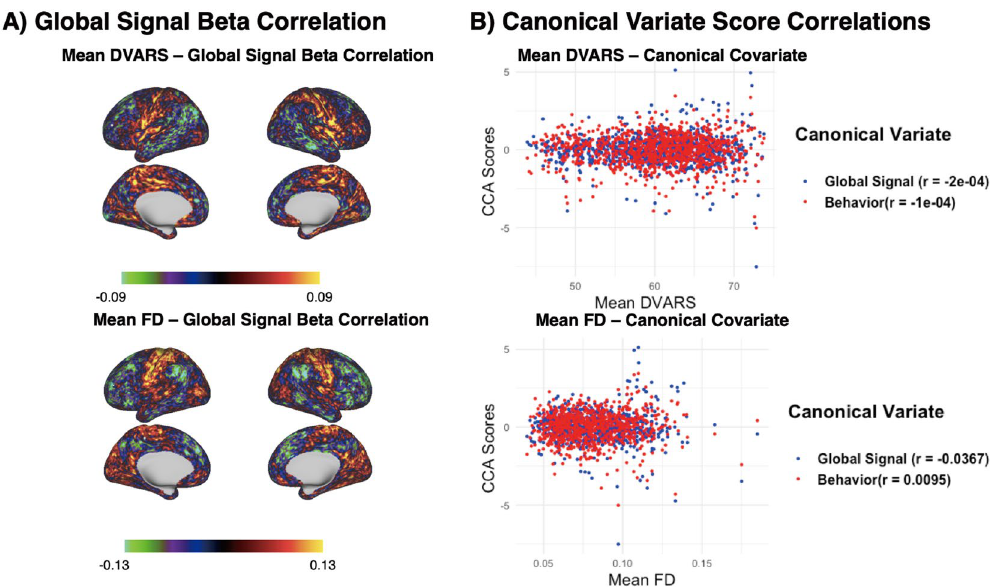
Figure 4. Correlation of Global Signal Estimates with Head Motion. ( A ) Per-vertex correlation between global signal beta estimates and average head motion (FD and DVARS) across subjects. ( B ) Scatter plots between global signal (blue) and behavioral (red) CCA scores and average head motion (FD and DVARS). Estimated Pearson correlation coefficients ( r ) are displayed in the legend beside each